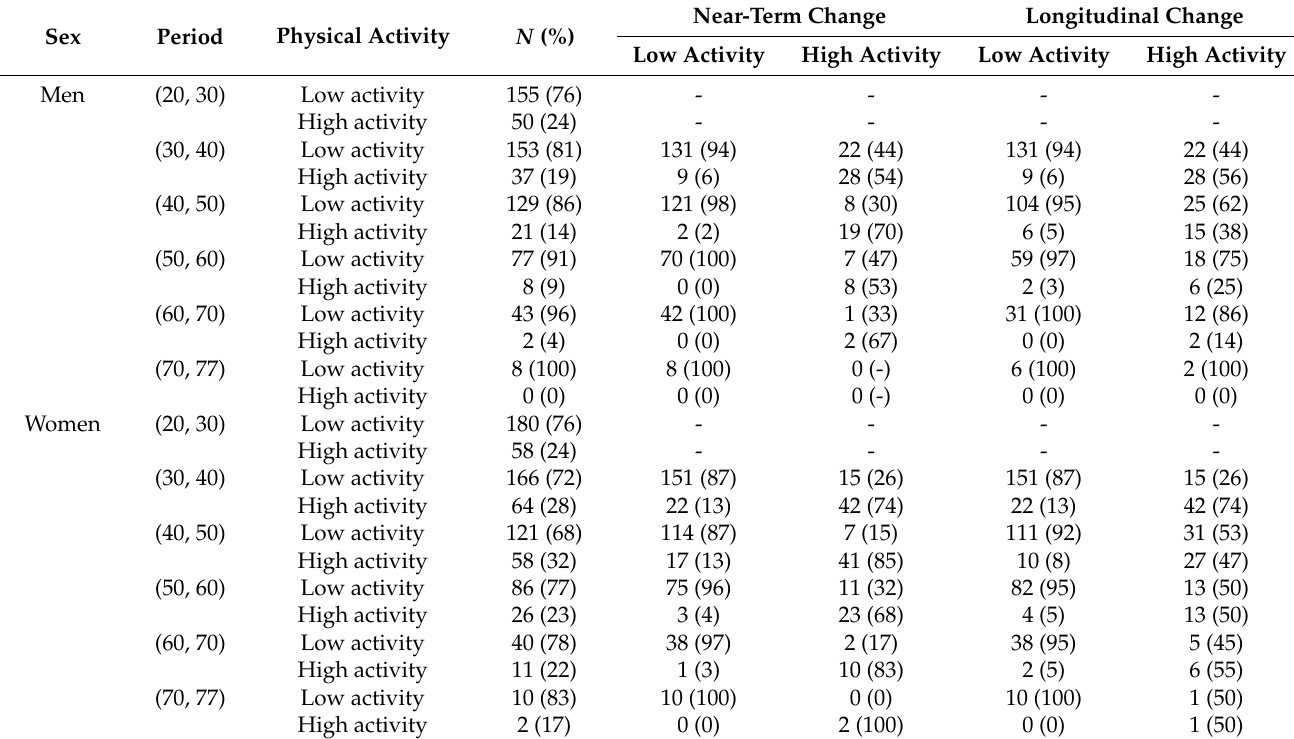
Table 5. Frequencies and cross-period tables for participation in organized physical activity in 10-year periods among participants with Lynch